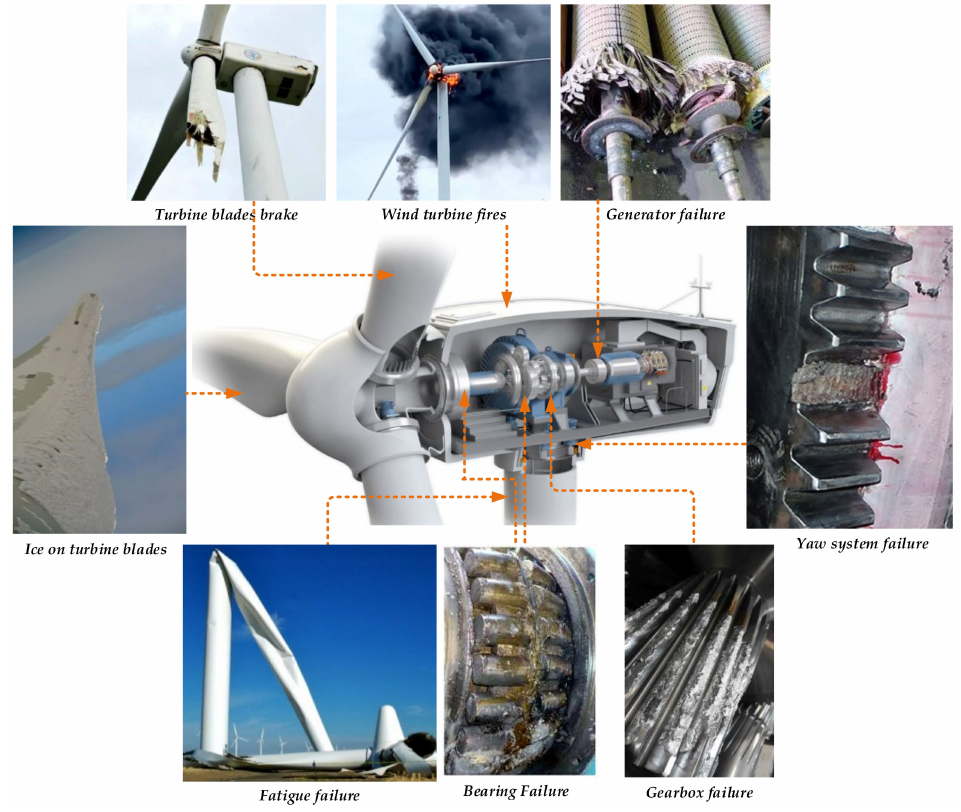
Figure 1. Main components of a horizontal wind turbine, and their corresponding